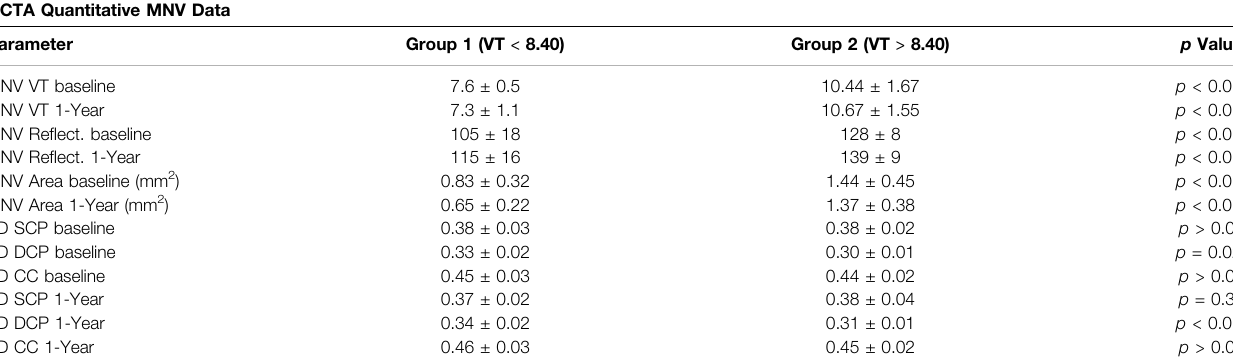
TABLE2| OCTAquantitativeMNVdata.Thefollowingabbreviationsareused:macularneovascularization(MNV),vesseldensity(VD),super fi cialcapillaryplexus(SCP),deep capillary plexus (DCP), choriocapillaris (CC). OCTA Quantitative MNV Data